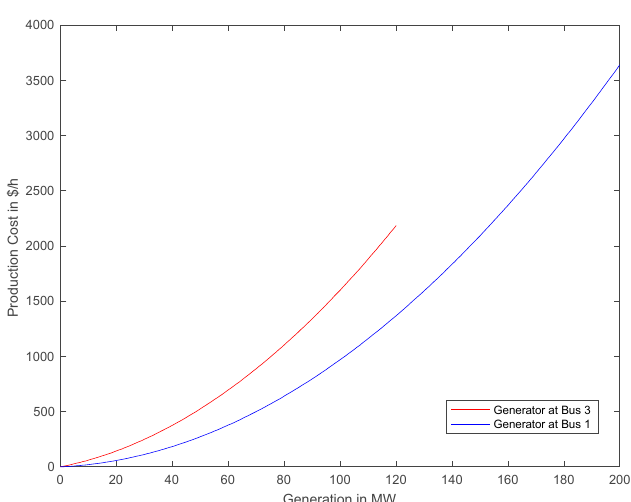
Figure 5. Production costs of the generators located at Bus 1 and Bus 3, GC 1 = 0.11 g 2 + 1.2 g GC 3 = 0.085 g 2 3 3